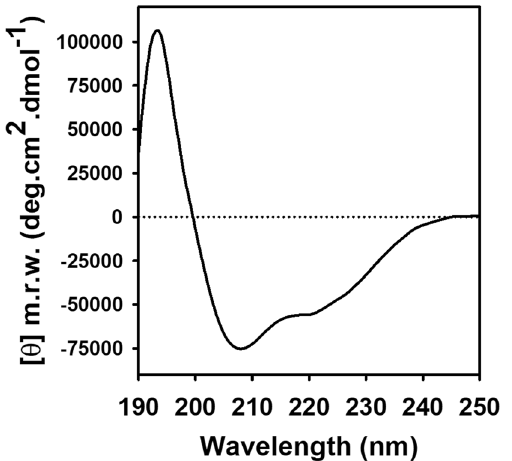
Figure 6. Secondary structure analysis of purified hTAS1R2 using circular dichroism spectroscopy. The far UV CD spectrum of hTAS1R2 recorded in PBS at 0.1% LMNG pH 7.3 shows the presence of a high content of α-helical secondary structures. Protein concentration 1 mg/mL. Light path 0.01 cm.